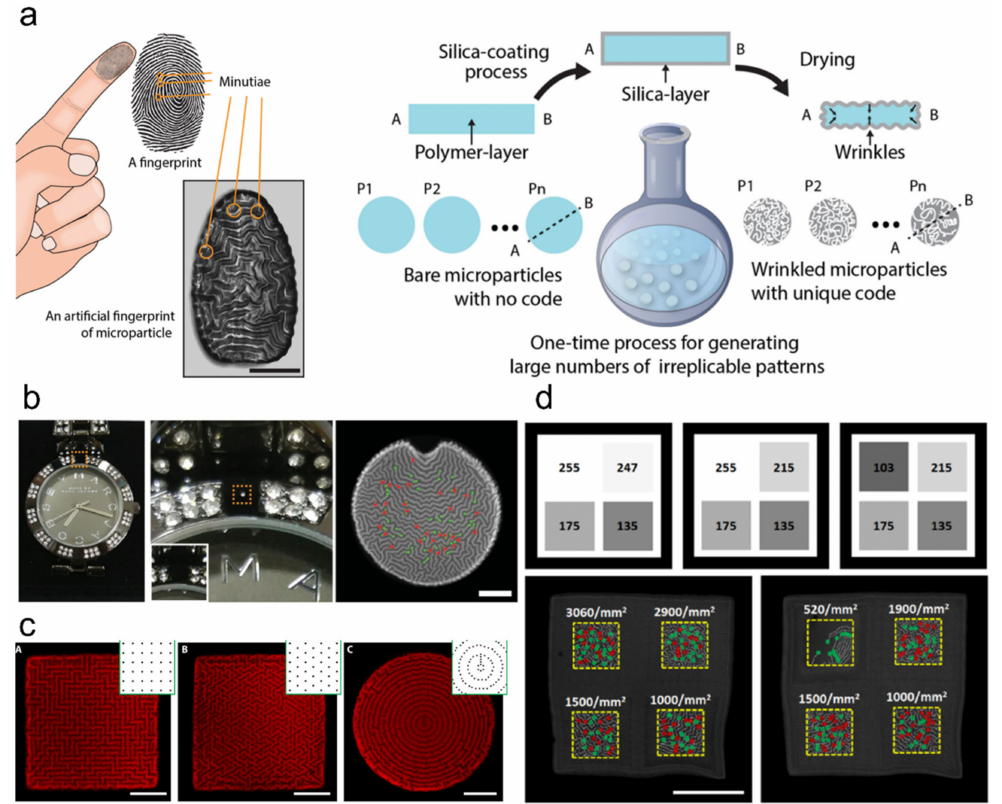
Figure 15. ( a , b ) Schematic ( a ) and demonstration ( b ) of human fingerprint-like microparticle-based product anti-counterfeit tagging. Drying of thin silica layer-coated PEGDA microparticles induces random surface wrinkle generation, which is different for every particle. These unique winkling patterns can be utilized as authentication taggants; scale bar is 100 µ m; adapted with permission from [178]. Copyright 2015 Wiley. ( c ) Demonstration of hydrogel microparticles with physical mazes based on guided wrinkle patterning; scale bars are 25 µ m; adapted with permission by the authors of [179]. Copyright 2017 AAAS. ( d ) Demonstration of gradient wrinkling for higher security level anti-counterfeiting; scale bar is 100 µ m; adapted with permission by the authors of [180]. Published under CC-BY-NC-ND